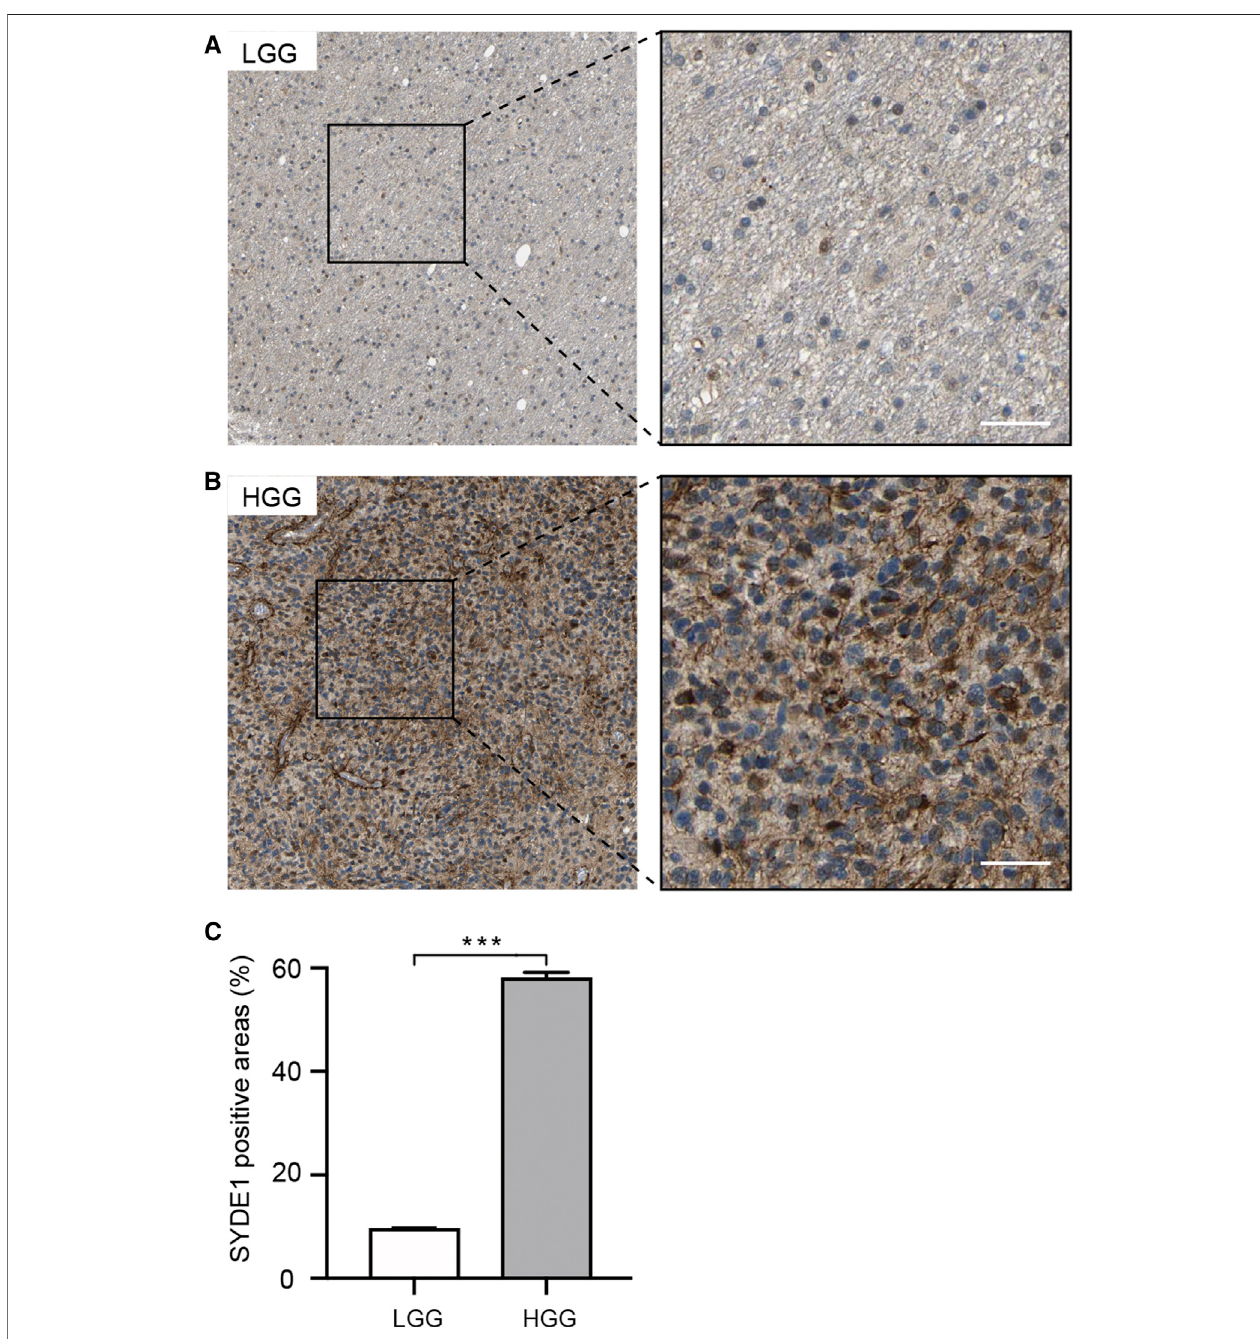
FIGURE 4 | Immunohistochemical analyses of SYDE1 expression in LGG and HGG (The HPA database). (A) Weak SYDE1 staining in LGG. (B) Strong SYDE1 staining in HGG. (C) Quanti fi cation of SYDE1 positive areas in LGG and HGG. ***, p.value < 0.001; Scale bars (cid:1) 50 μ m.